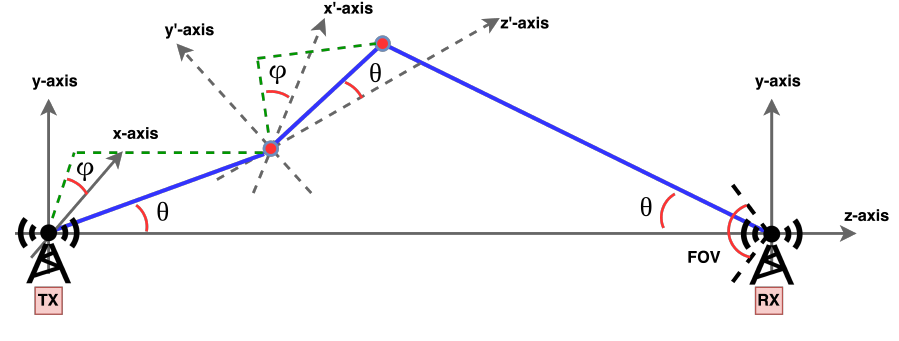
Figure 3. Variation of θ from Tx towards